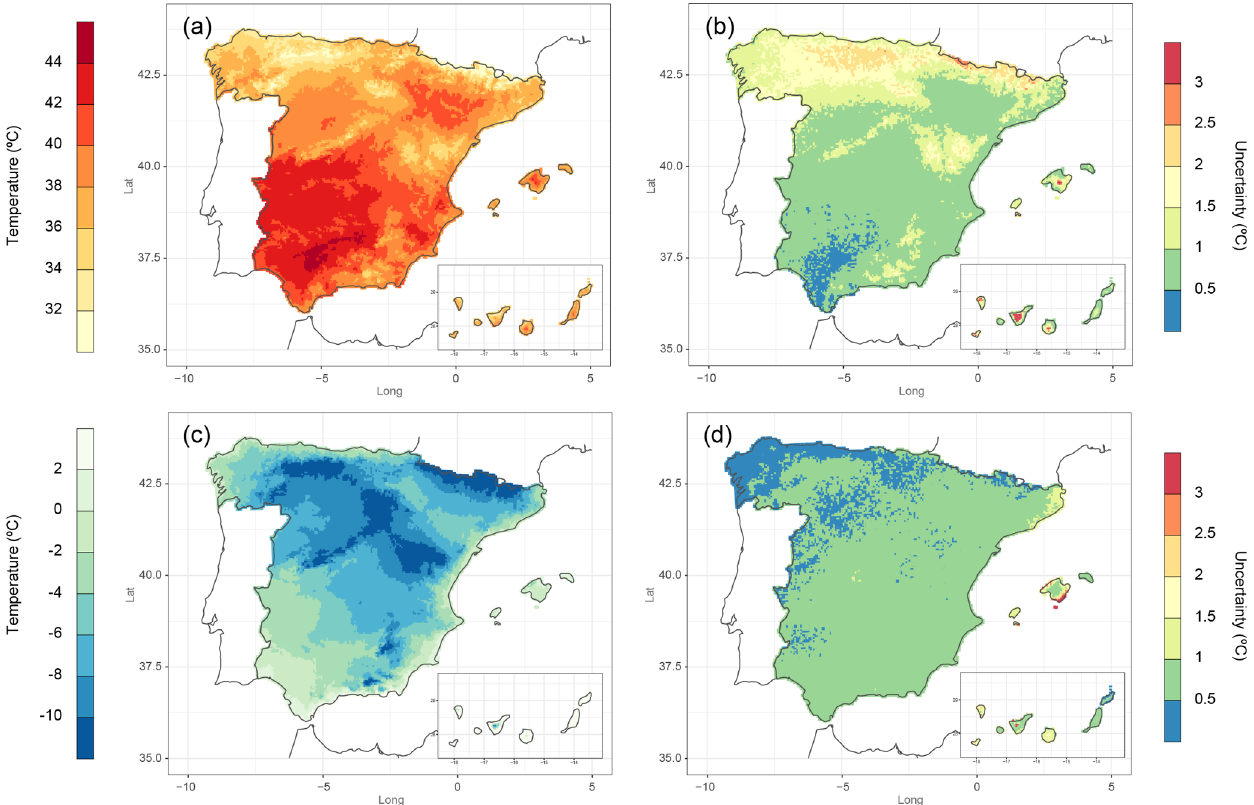
Figure 12. Mean annual (1981–2010) values for (a) absolute daily maximum temperature, (c) absolute daily minimum temperature and their corresponding uncertainty ( b, d ,